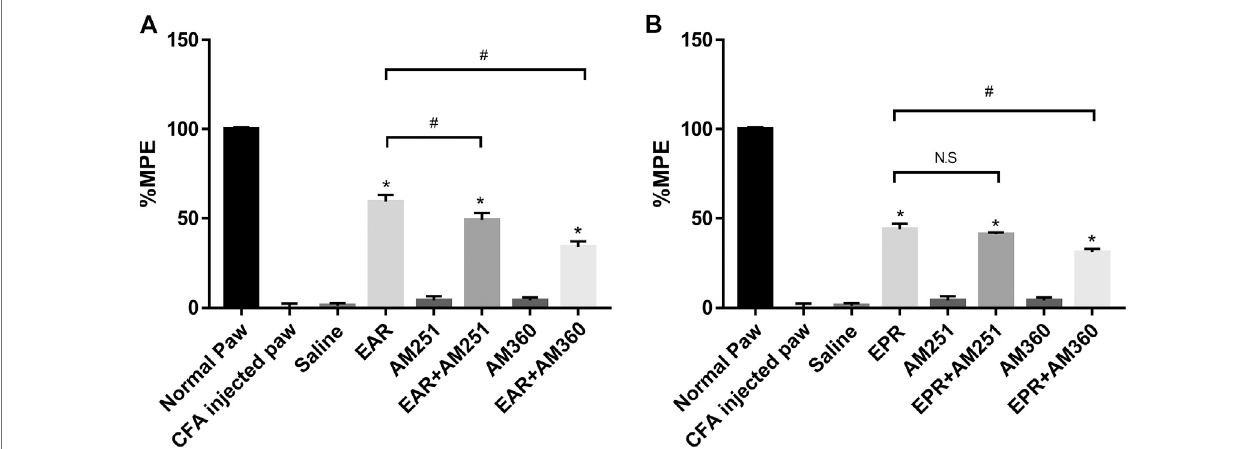
FIGURE 6 | Effect of the oral administration of (A) E. angustifolia root extract (EAR) or (B) E. purpurea root extract (EPR) and cannabinoid receptor antagonists AM251(CB1)andAM630(CB2)onperipheralpaininrats.Dataarepresented as%ofmaximumpossibleeffect(%MPE),relativetotheNormalPawgroup,asafunction ofdose.Dataarethemean ± SEMfor6animals.*Signi fi cantlydifferentfromthevehicle(Saline)group( p < 0.01);#Signi fi cantlydifferentfrom theEARwithoutantagonist group ( p < 0.01). as determined by ANOVA analysis followed by post hoc Dunnett ’ s t-test. N.S: not signi fi cant ( p > 0.05).